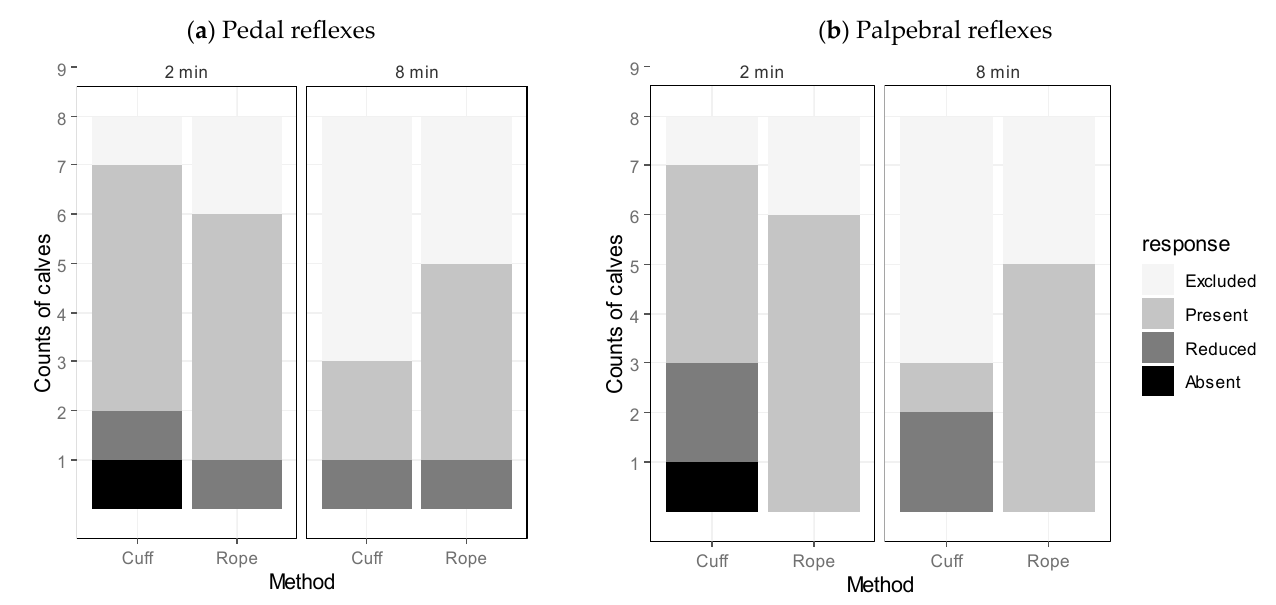
Figure 6. Comparison of ( a ) the pedal reflex responses, and ( b ) the palpebral reflex responses at 2 min and 8 min into the thoracic squeeze for each method of application. “Excluded” refers to calves that did not have their reflexes tested for logistical reasons, or because the squeeze had already been discontinued. “Present” refers to a full limb withdrawal; “Reduced” refers to a slight limb withdrawal; “Absent” refers to a lack of limb responses to reflex testing.